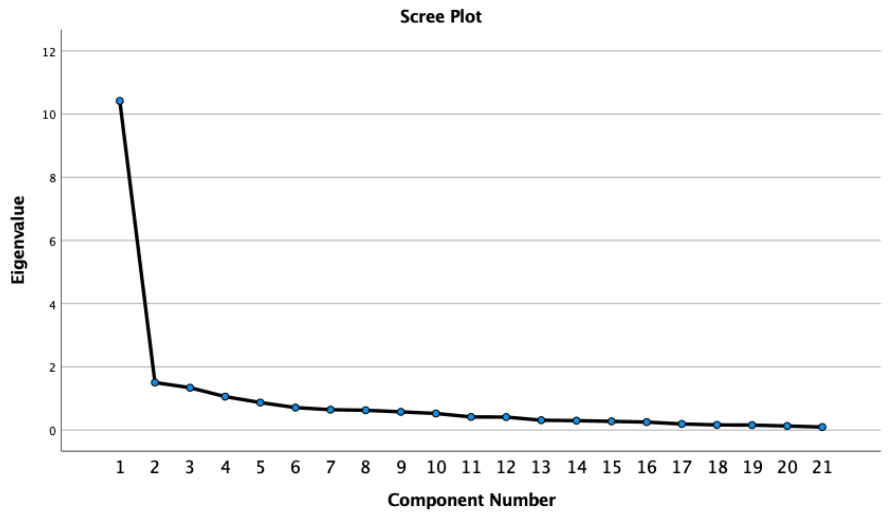
Figure 2. Scree plot representing the eigenvalues (21-item Resilience Scale). The correlations between Factor 1, Factor 2, Factor 3, and Factor 4 were significant, ranging between 0.538 and 0.799 (Pearson coefficient ( r ) ≥ 0.30) (Table 7). Table 7. Pearson correlations between extracted factors ( n = 104). Pearson Correlation between Extracted Factors